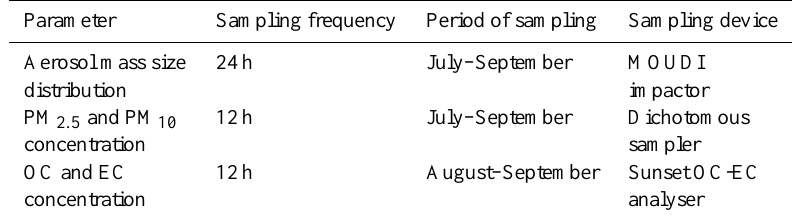
Table 1. Description of aerosol sampling campaigns performed at